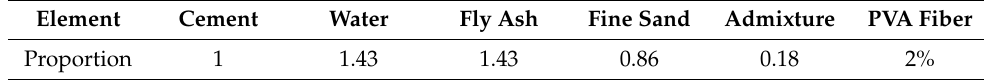
Table 2. Mix proportion of ECC.